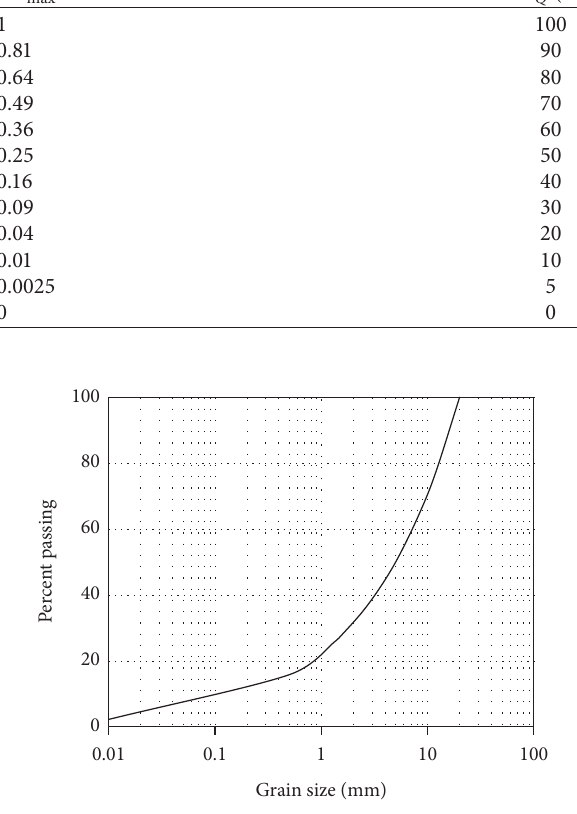
Figure 9: Grain size distribution curve of a modeled sample produced by using quadratic